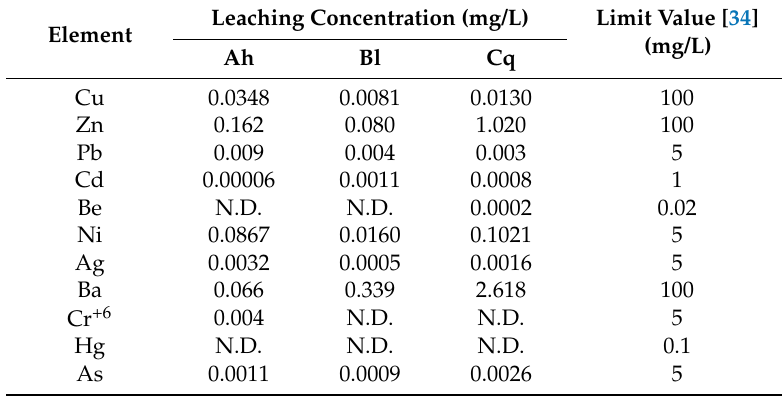
Table 1. Determination of inorganic elements in excess sludge